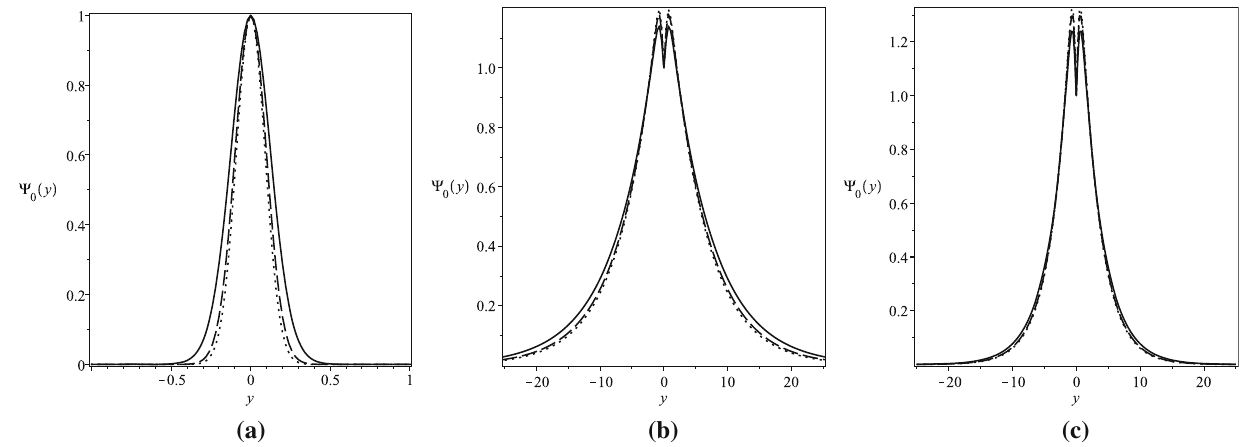
) . In all figures we 2 − T